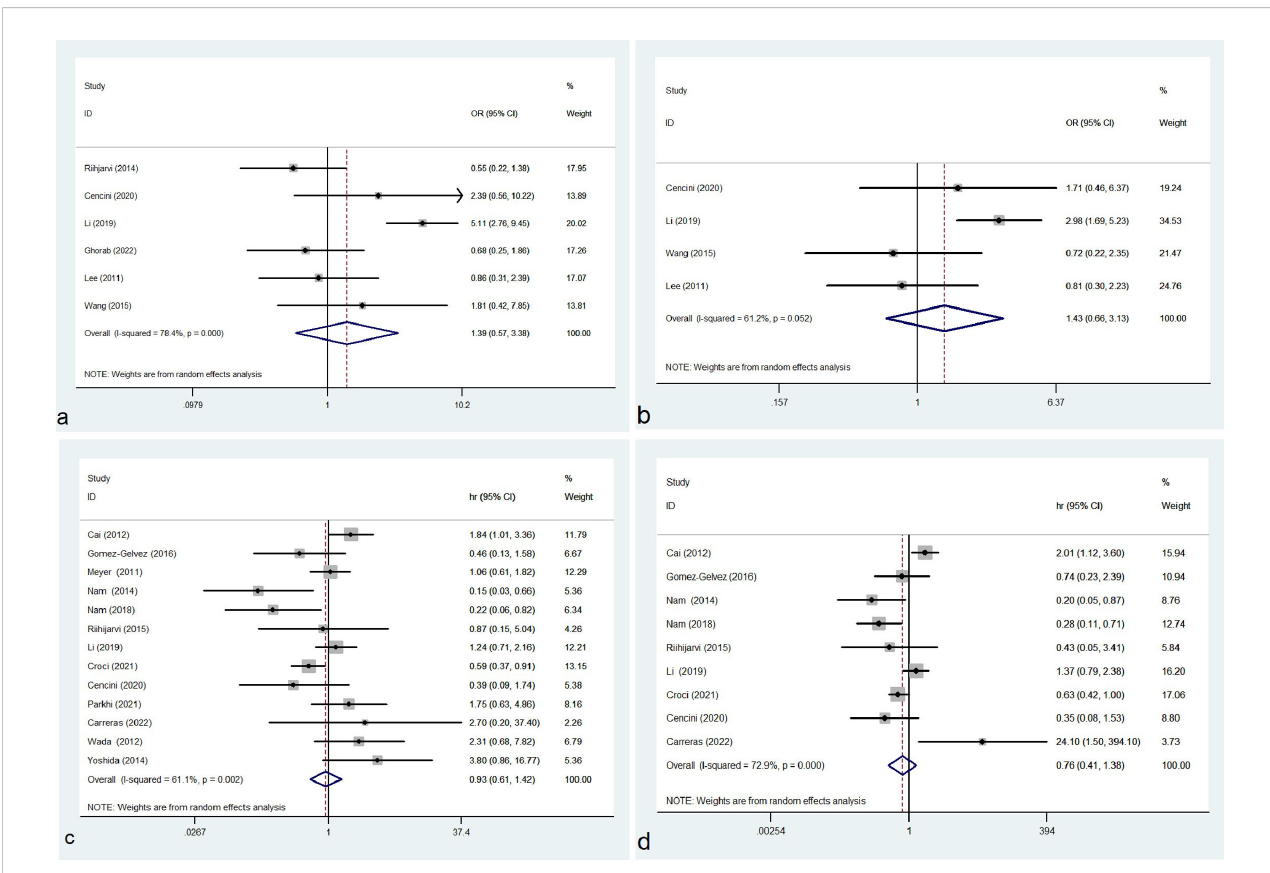
FIGURE 2 Forest plot of total TAMs and IPI (A) , disease stage (B) , OS (C) and PFS (D) ; OR, odds ratio; hr, hazard ratio; CI, con fi dence